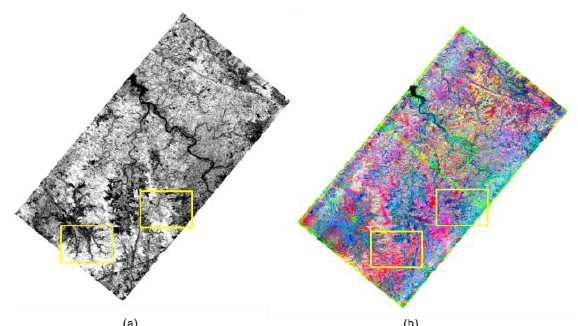
Figure 4. DESIS datasets (a) MNF 4 (b) MNF Indices R=3